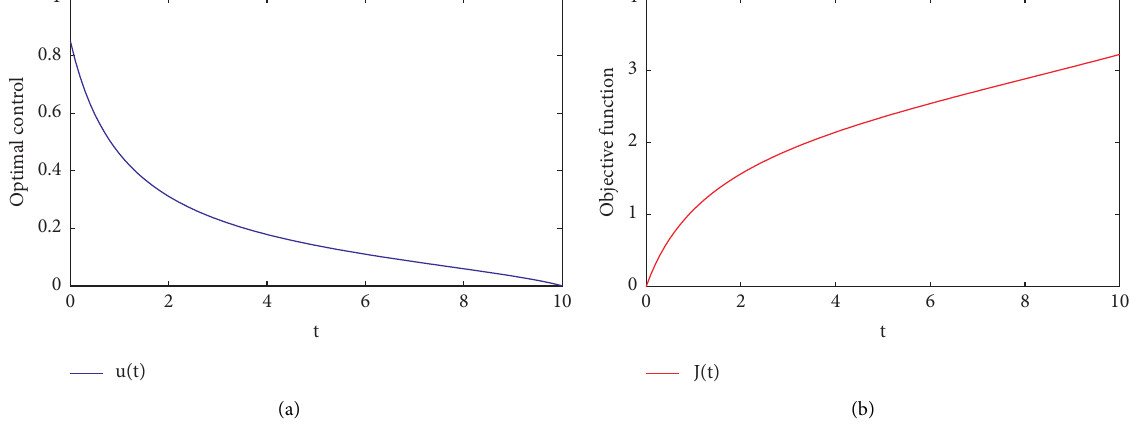
Figure 7: (a) The path of optimal control u ( t ) . (b) The path of control costs J ( t ) .